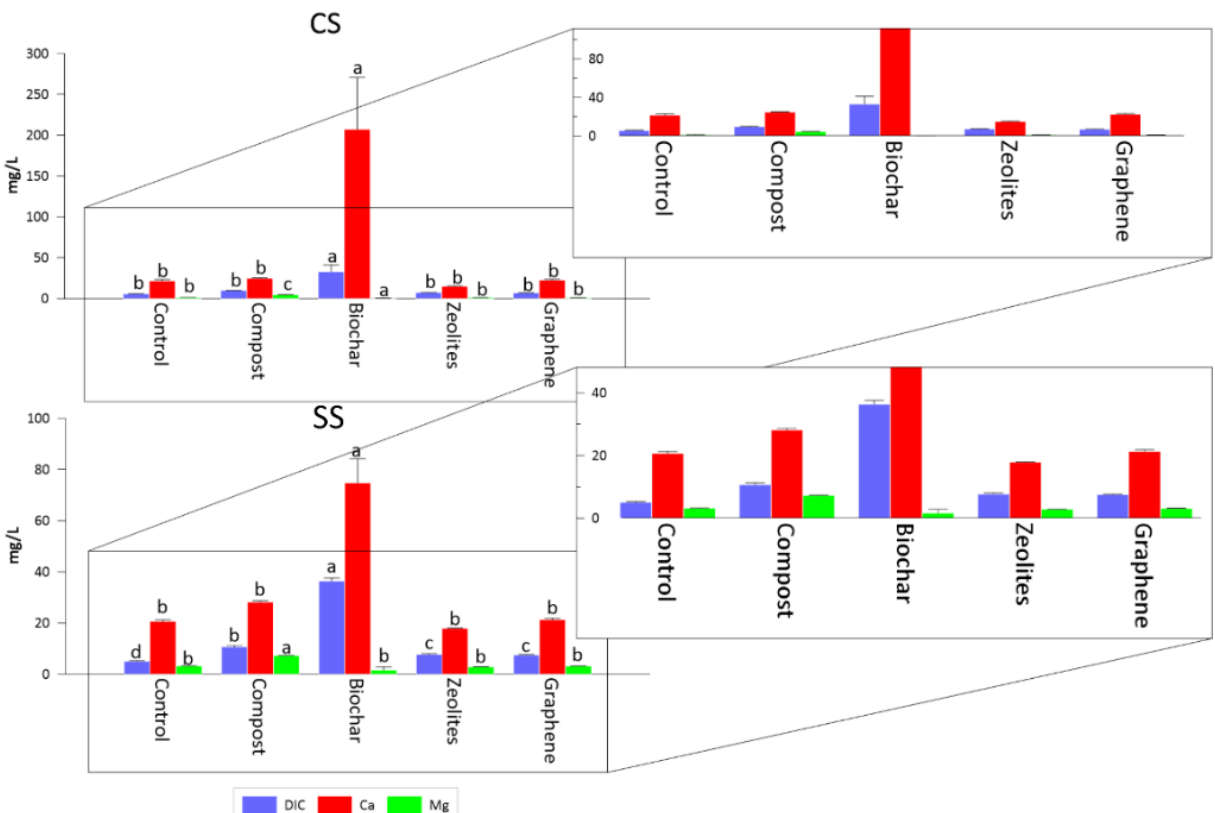
Figure 9. DIC, Ca and Mg concentrations in SSE batches with CS ( upper panels ) and SS ( lower panels ) soils at L/S = 5 at the end of the monitoring period. Error bars denote standard deviations calculated on three replicates, while different letters indicate significative statistical